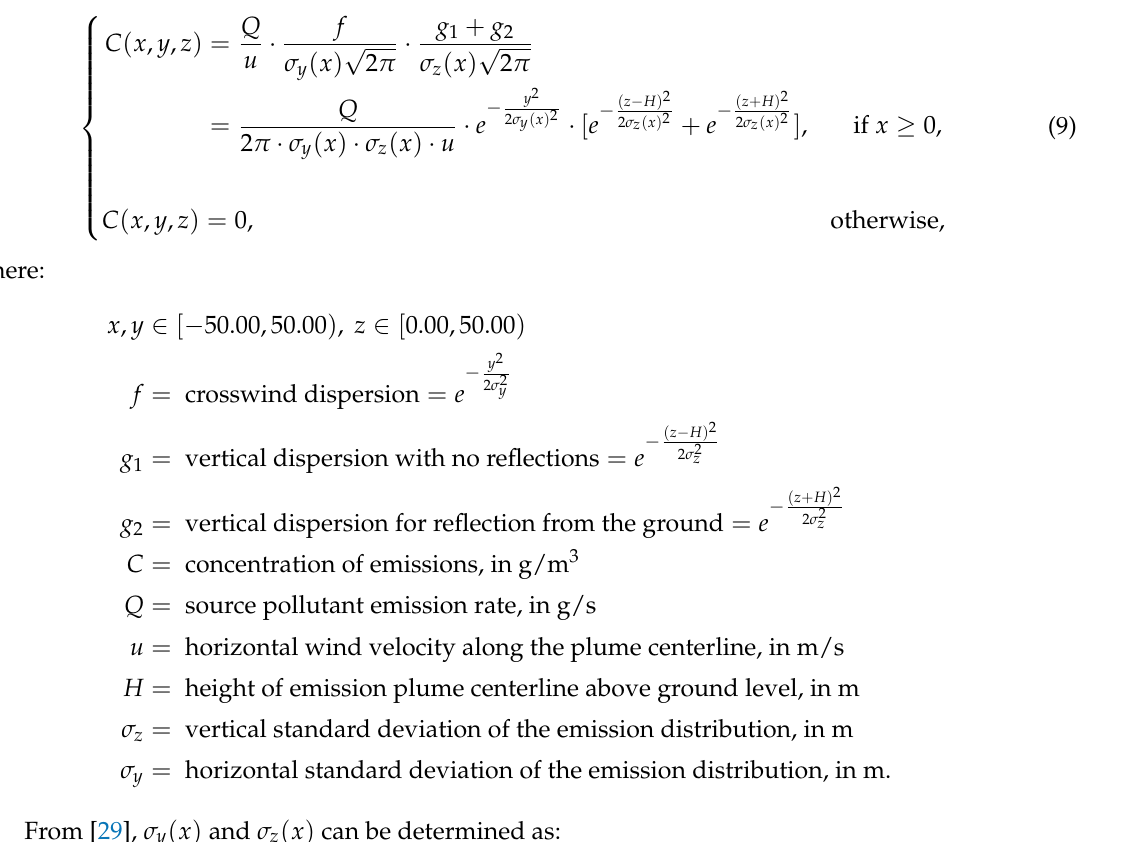
Fig. 1 Plume dispersion: definition sketch Figure 3. The visualization of the Gaussian air pollutant dispersion on x - and z -axes. The Gaussian air pollutant dispersion equation can be written